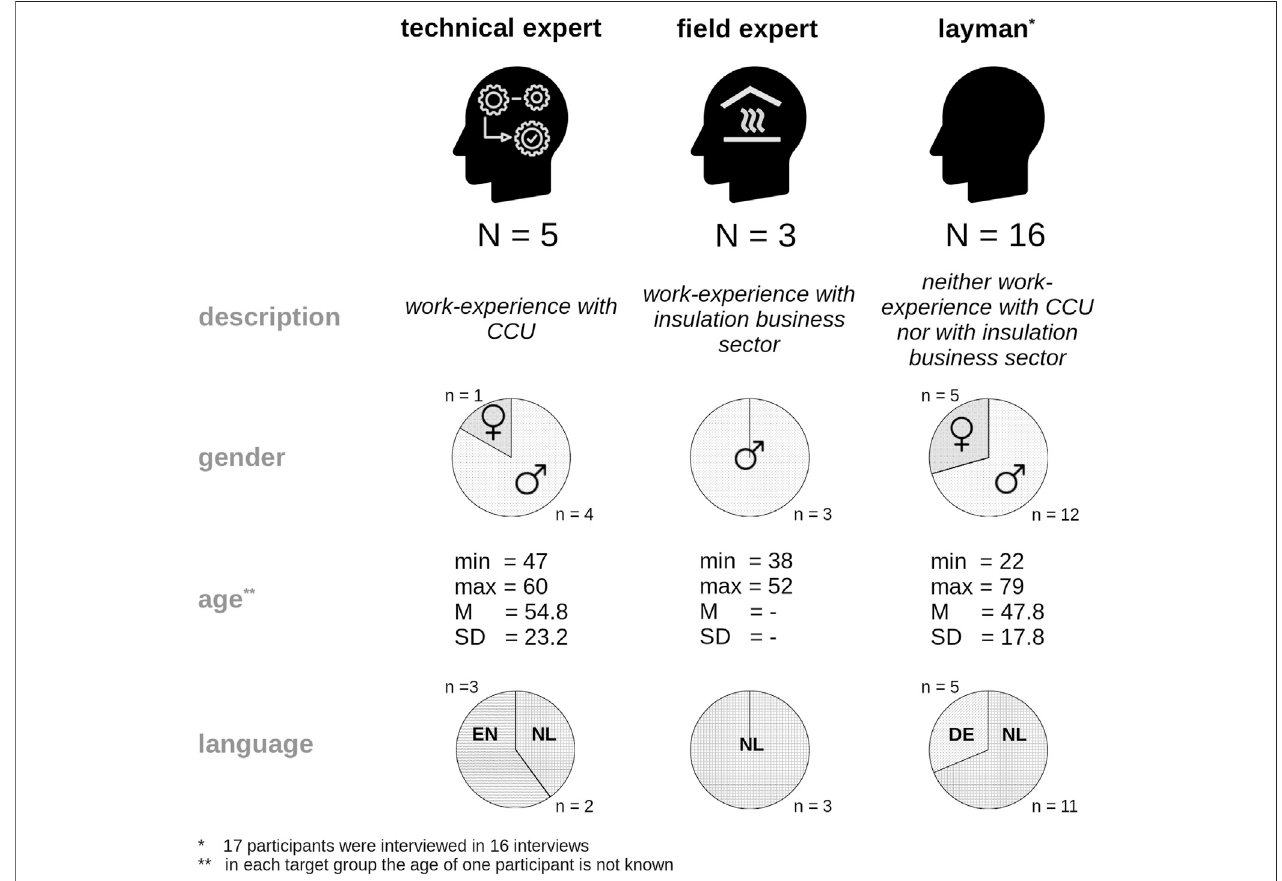
FIGURE 1 | An overview of the available descriptive data on the interviewees sorted by the target